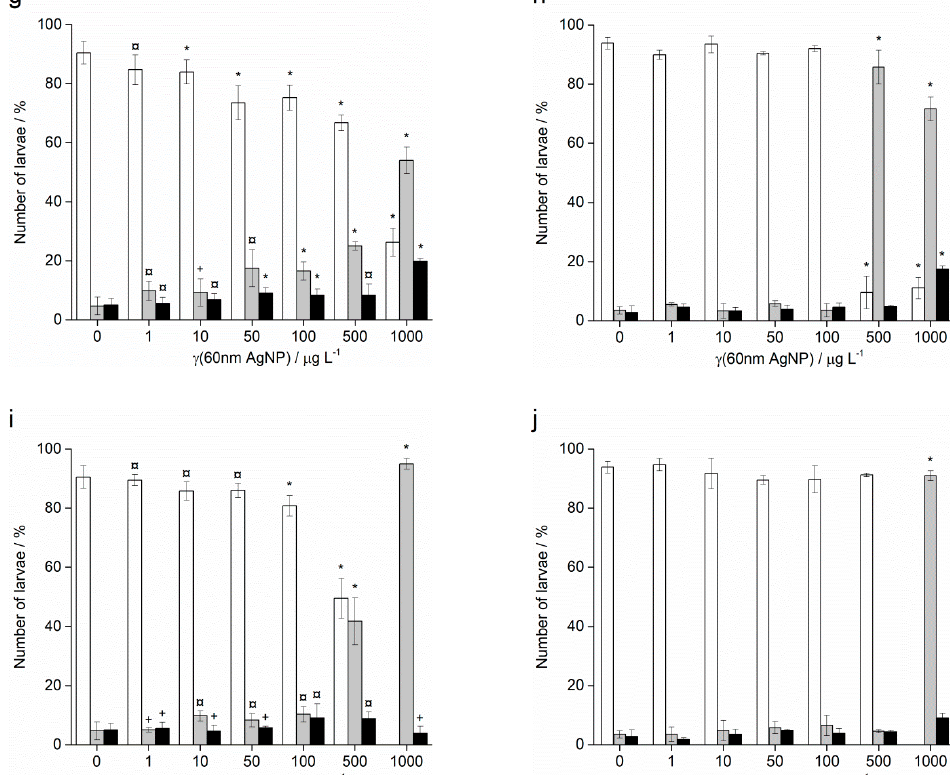
Figure 5. Percentage of normal (white bars) and developmentally delayed or defective (grey bars) larvae, and undeveloped embryos (black bars) ( ± SD) of urchins A. lixula (left bar charts) and P. lividus (right bar charts) exposed to AgNPs of diameter ( a , b ) 10 nm, ( c , d ) 20 nm, ( e , f ) 40 nm, ( g , h ) 60 nm, and ( i , j ) 100 nm. Significance levels: + p < 0.05, ¤ p < 0.01 and * p < 0.001.